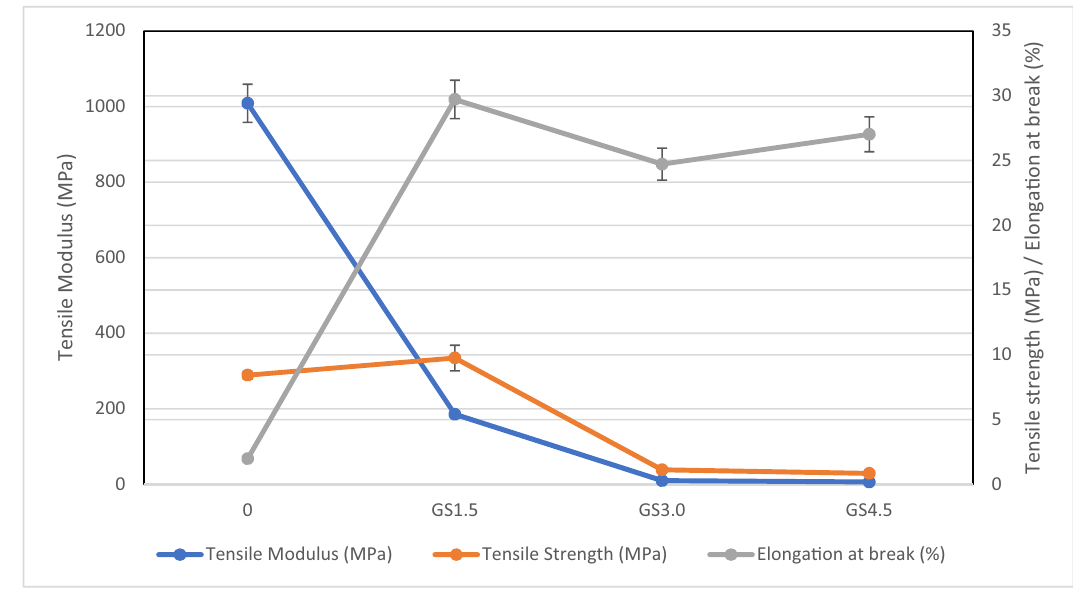
Figure 8: Mechanical properties of GS - plasticized fi